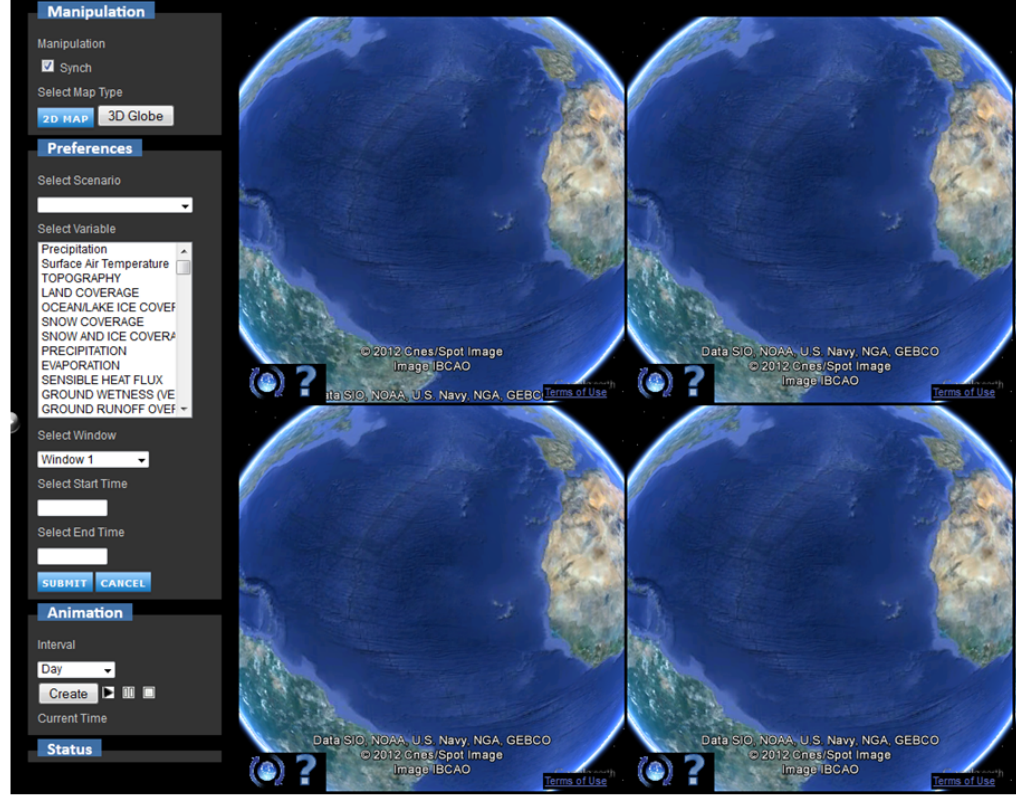
Figure 6. System interface: End users can use the GUI (Graphical User Interface) to select the parameters, time, and region, to be reviewed at a specific window. Multiple windows (up to six and with four shown) can be synchronized as needed for